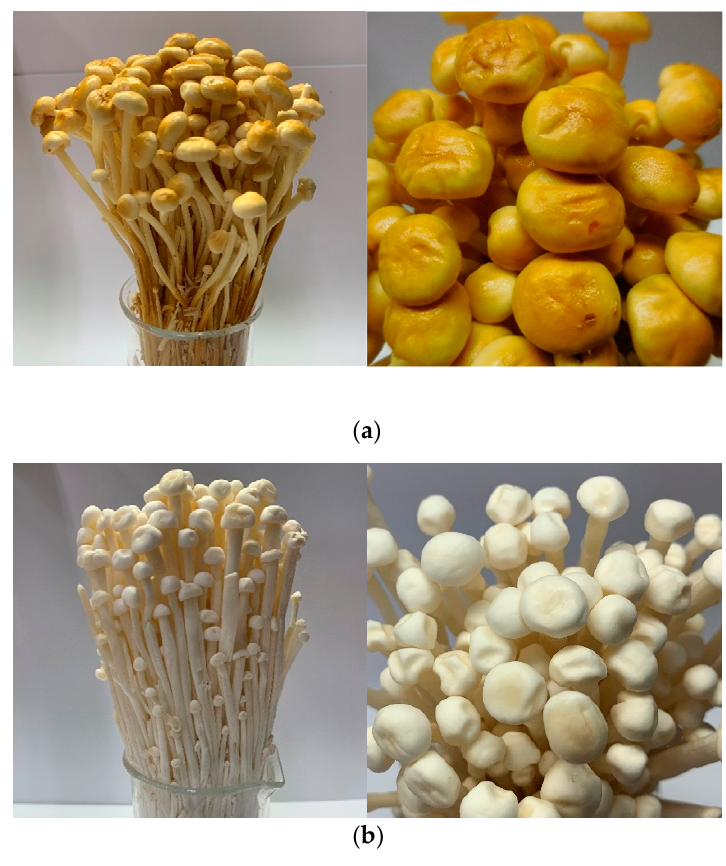
Figure 1. Two strains of F. velutipes : ( a ) yellow strain; and, ( b ) white strain.